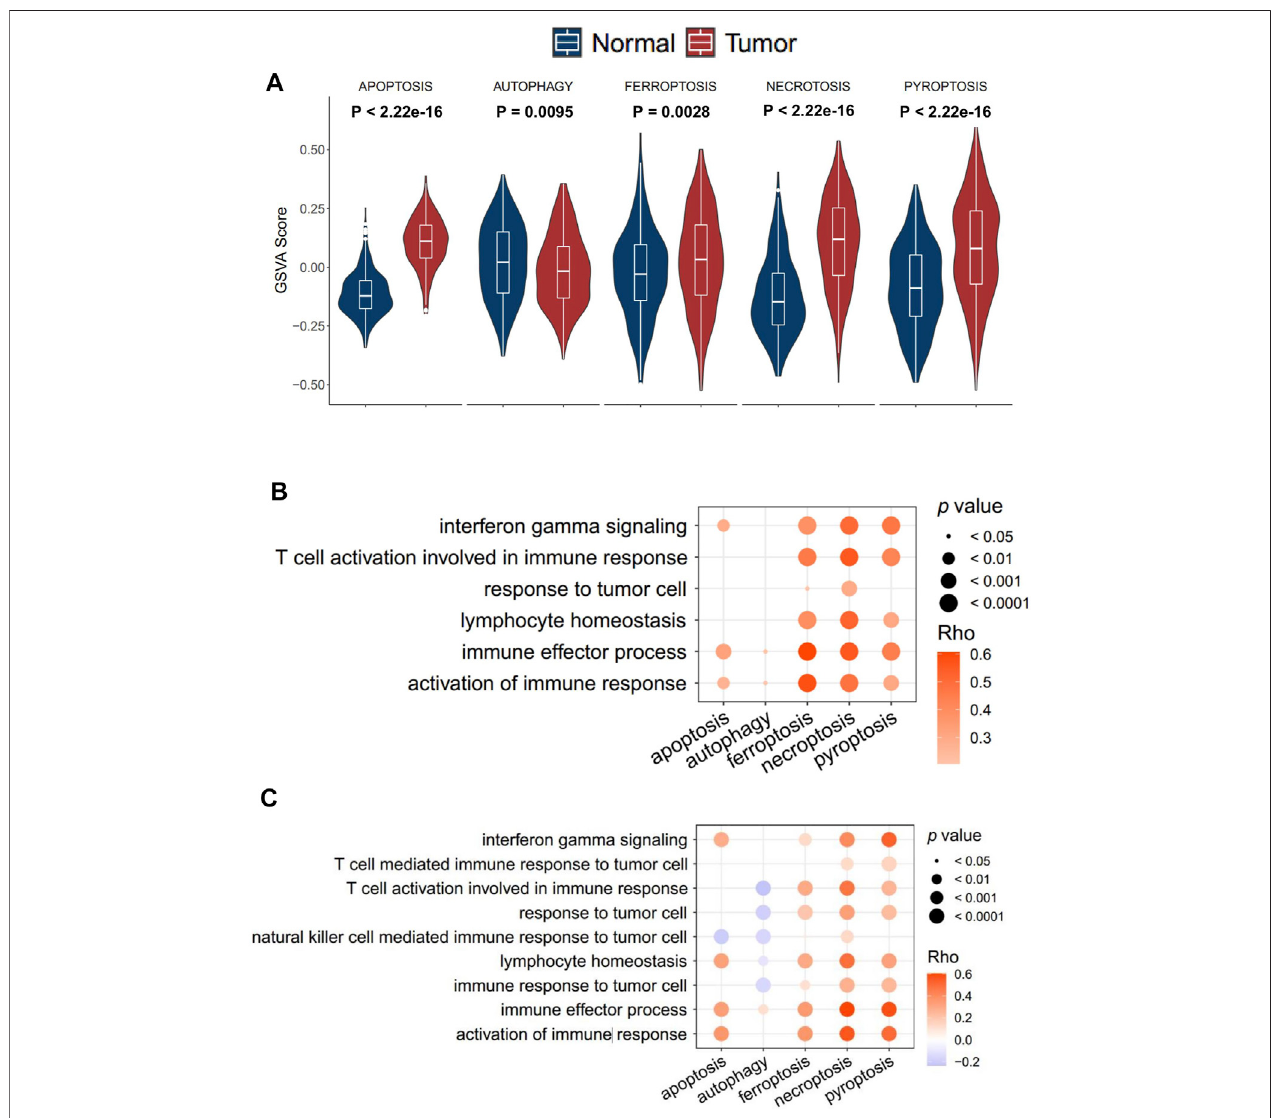
FIGURE 1 | Identi fi cation of the immune cell death pathway. (A) GSVA score of cell death signaling between tumor and normal tissue in the transcriptomics level; (B,C) correlation of fi ve cell death signaling and immune responding-related signaling in the transcriptomics level (B) and proteomics level (C) .